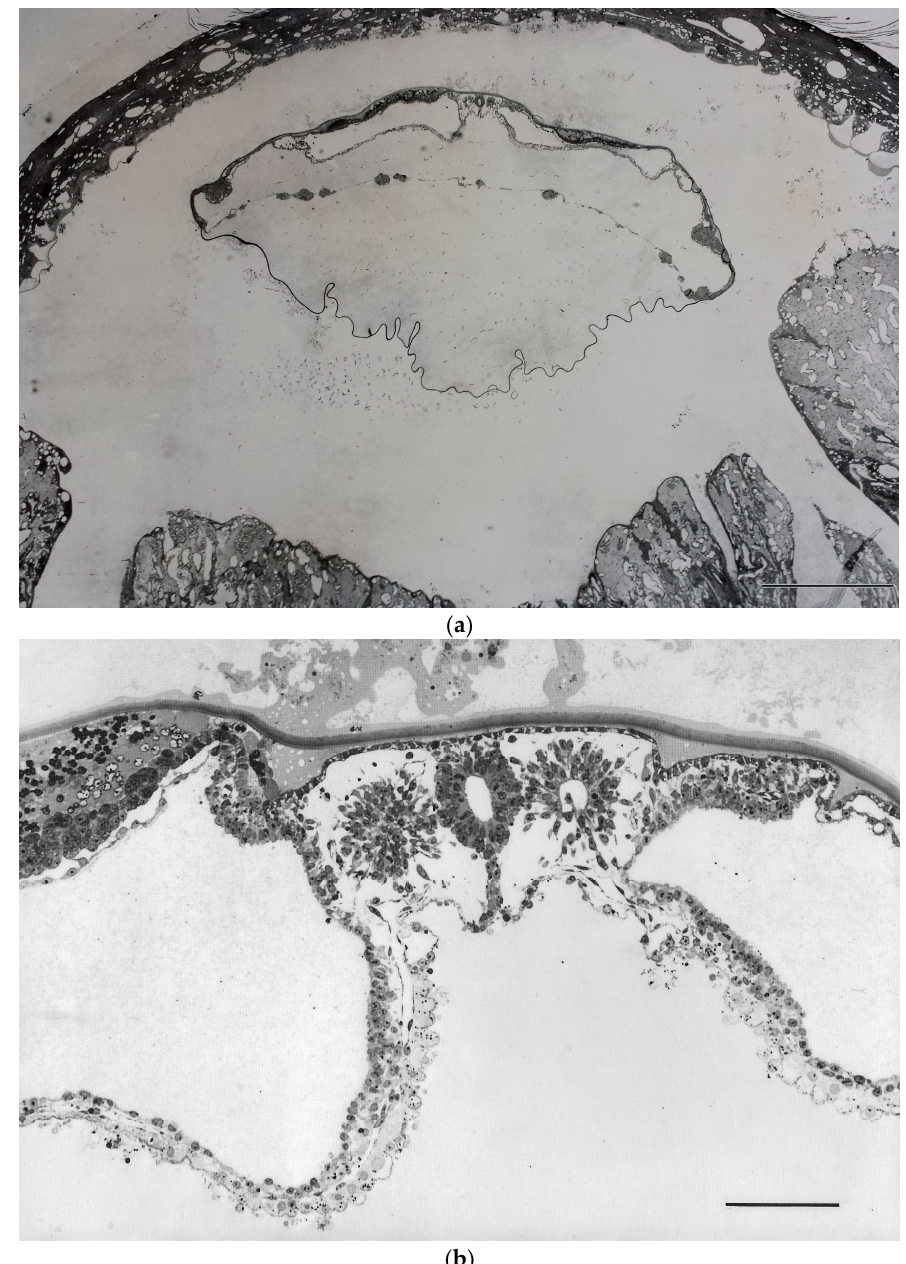
Figure 1. Basic body plan development has been shown to be independent of implantation in the uterus in vivo in rabbits. In these experiments, hatching of the blastocyst from its coats/coverings (zona pellucida equivalents) was blocked by continuous intrauterine infusion of a non-toxic proteinase inhibitor, aprotinin. As a result, the embryo shown here is still completely encased in its glycoprotein coats, and the trophoblast has not been able to attach to the endometrium and start its hemochorial placentation. Nevertheless, early embryonic pattern formation processes (basic body plan) have not only set in, but have continued to a remarkable degree, thus demonstrating independence of implantation. The stage shown is 9 ½ days post coitum, i.e., 2 ½ days after implantation has started in the controls. Spaces between the surfaces of the conceptus and the endometrium are exaggerated due to shrinkage during dehydration and Araldite embedding. ( a ) Overview; bar = 1 mm; ( b ) higher magnification of anlage of embryo proper; bar = 100 µm. Neural tube, notochord, somites, somatopleure and splanchnopleure etc. show normal morphology. Reproduced with permission, from [33] (a,b); [34] (a).